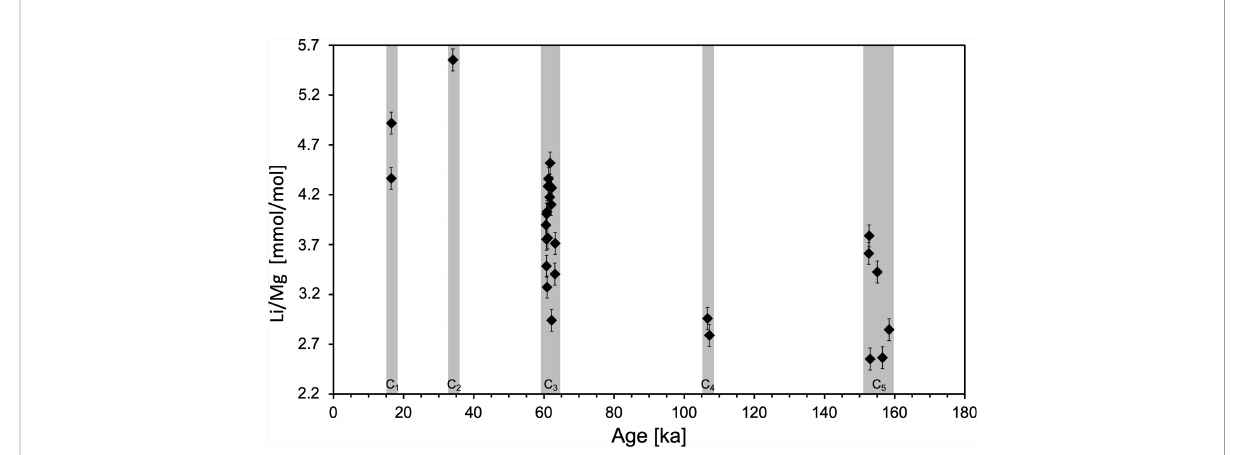
FIGURE 4 Li/Mg [mmol/mol] ( ± 0.11 2SD) measurements of fossil S. variabilis of the past 180 ka, subdivided in intervals